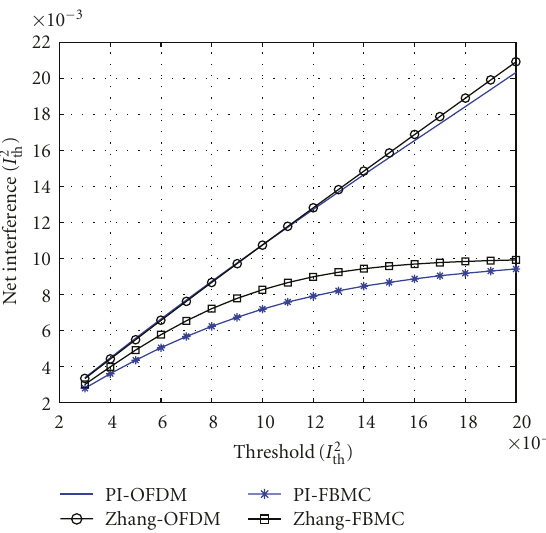
Figure 7: Achieved capacity versus allowed interference threshold for OFDM- and FBMC-based CR systems—two active PU bands.